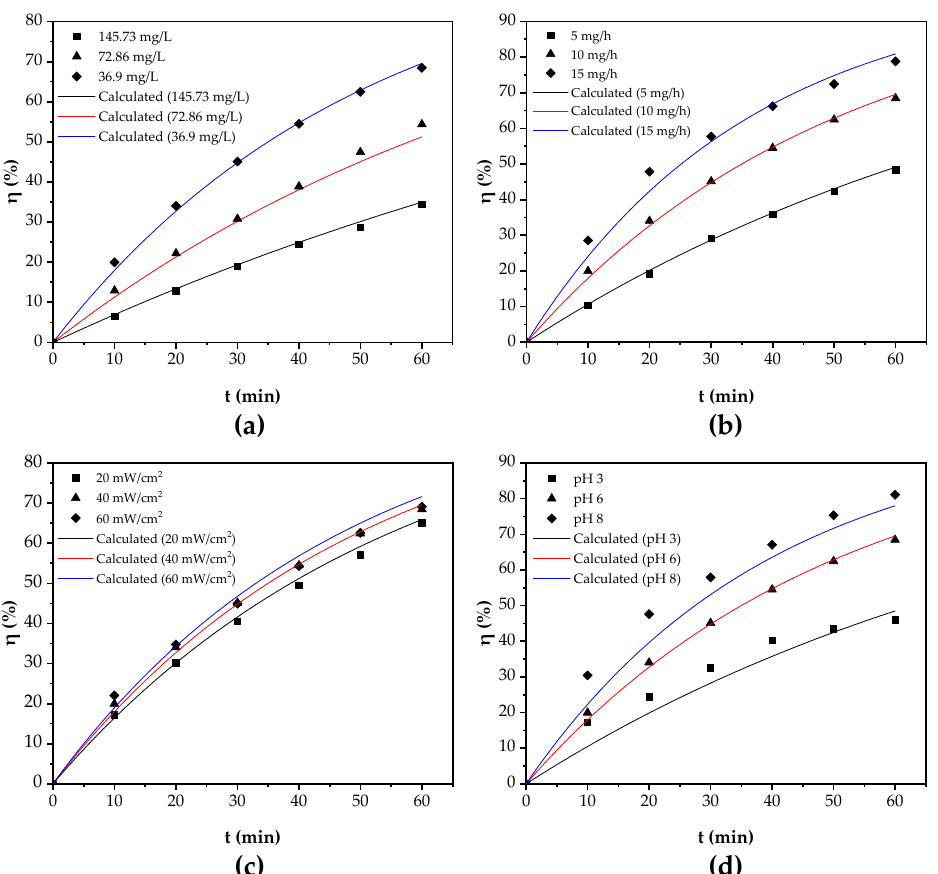
Figure 10. Comparison of data and calculated Cu removal efficiency at ( a ) varied C 0 , ( b ) varied C O 3 , ( c ) varied I UV , and ( d ) varied pH.